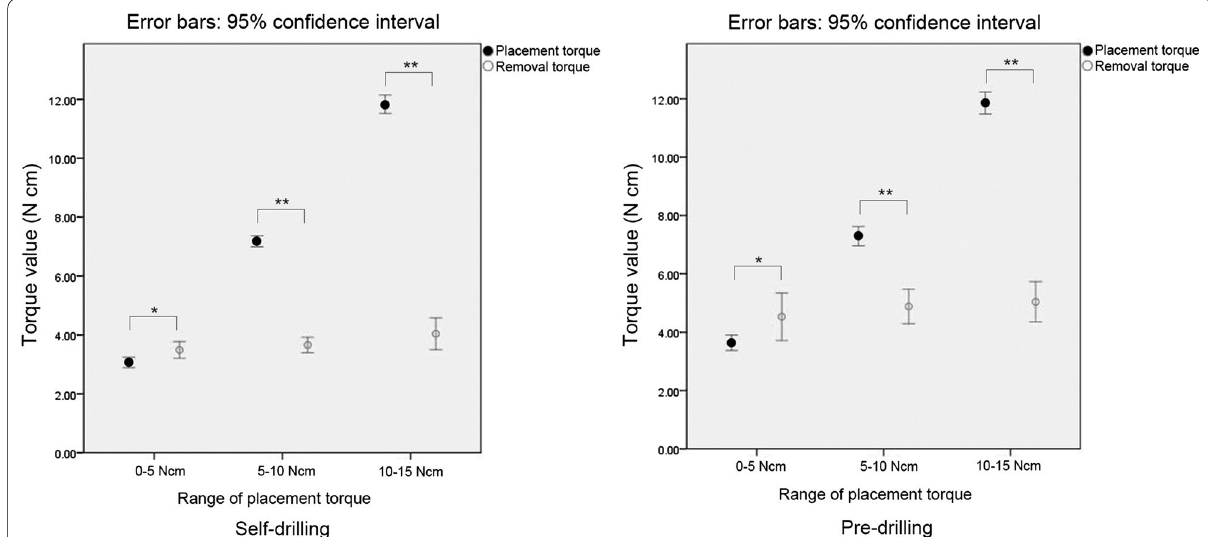
Fig. 6 Error bar plot of the mean placement and removal torque values according to the respective ranges of placement torque. * p < 0.05, ** p < 0.001